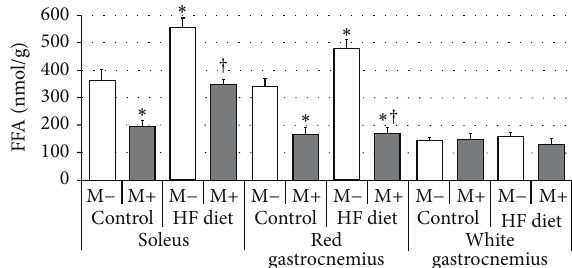
Figure 6: Effect of high-fat diet (HFD) feeding (5 weeks) and/or myriocin application (7 days) on free fatty acids (FFA) content in skeletal muscles ( 𝑛 (per group) = 8). M+: rats administered with myriocin. M − : untreated group. Results are expressed as means ± SD. ∗ 𝑝 < 0.05 compared with control group. † 𝑝 < 0.05 compared with HF diet